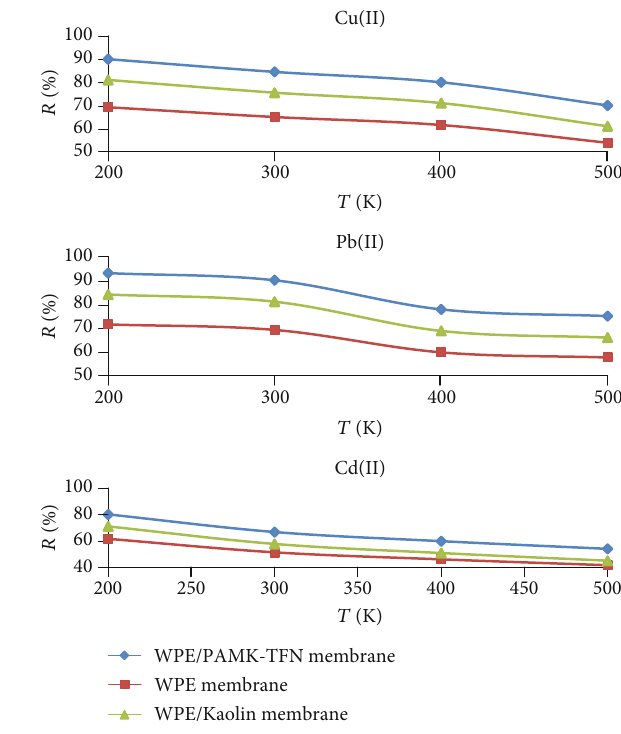
Figure 12: E ff ect of temperature on the fl ux of heavy metals on the prepared WPS, WPS/kaolin, and WPE/PAMK-TFN membranes.